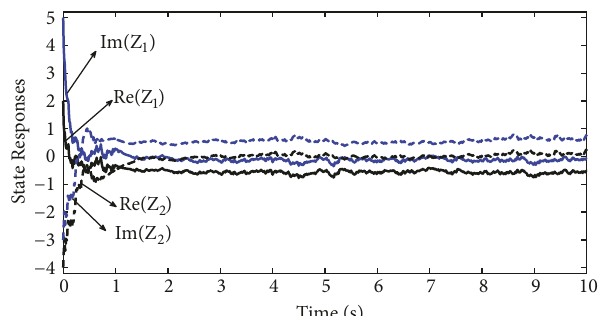
Figure 6: State curves of the real parts and imaginary parts in (52) with stochastic term.